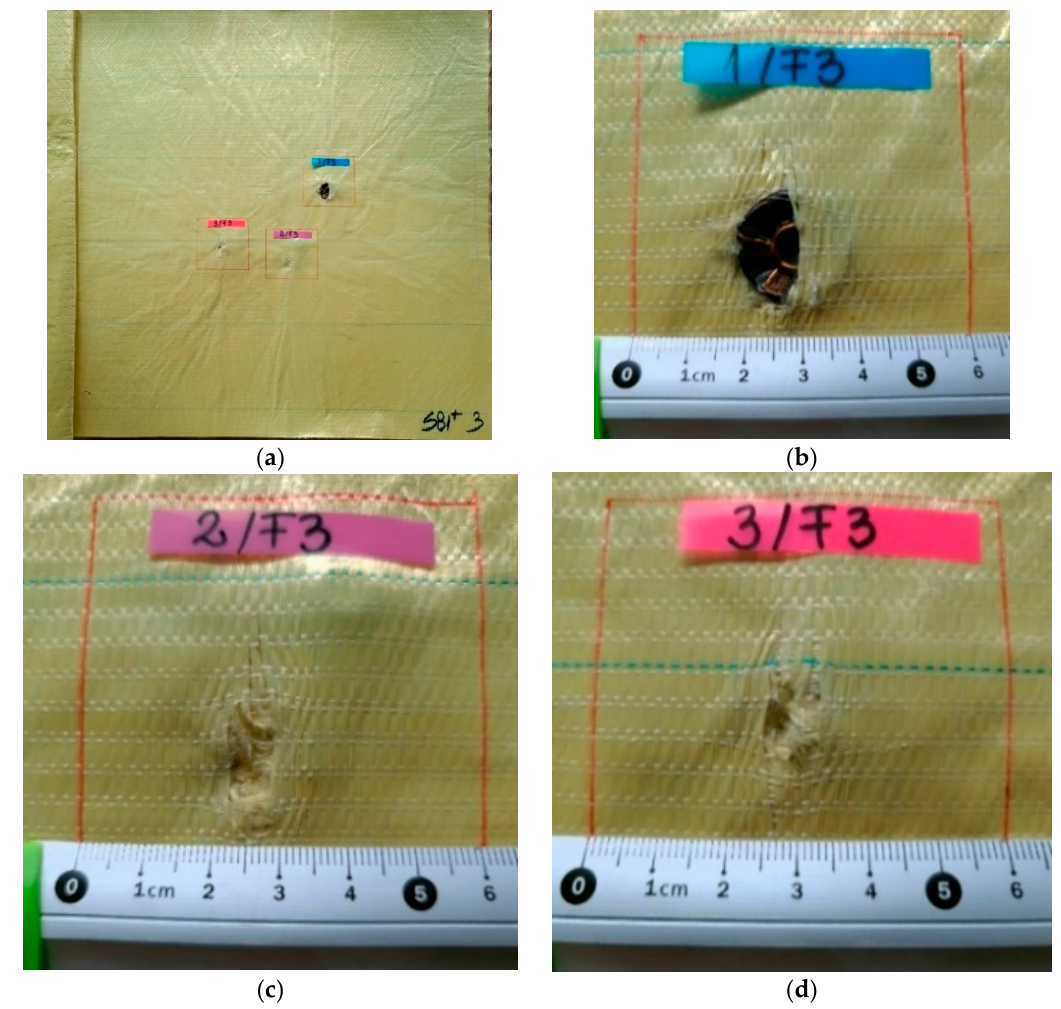
Figure 9. Frontal view of the sample with 12 layers of LFT SB1plus: ( a ) layer 3 (face), with details of the bullet holes of ( b ) fires 1, ( c ) fires 2 and ( d ) fires 3.